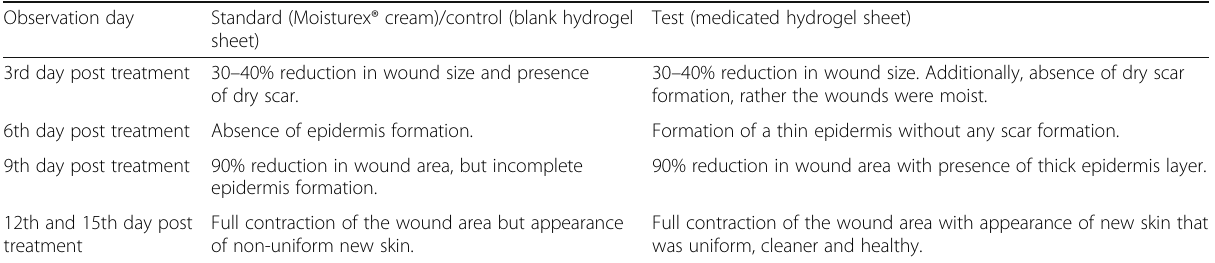
Table 2 Day-wise comparative healing for medicated hydrogel sheet against standard/control formulation Observation day Standard (Moisturex® cream)/control (blank hydrogel Test (medicated hydrogel sheet)